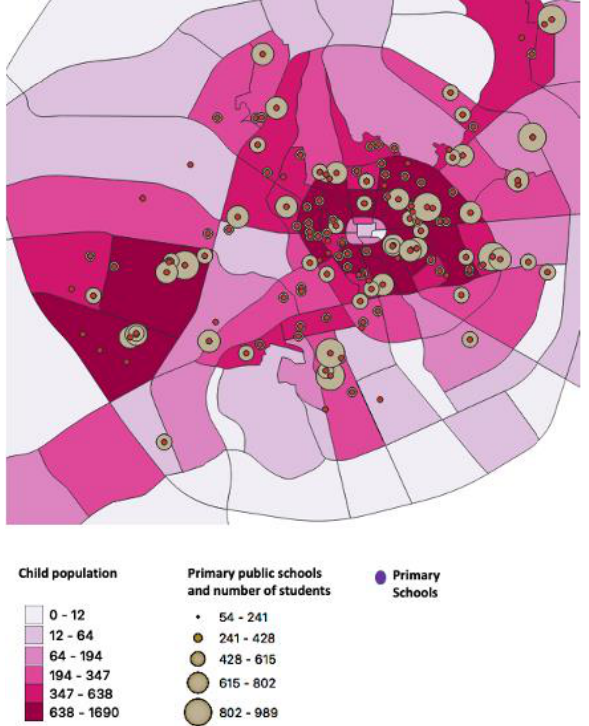
Figure 1. The distribution of the primary schools with the student population and the child population in Al-Madinah city.